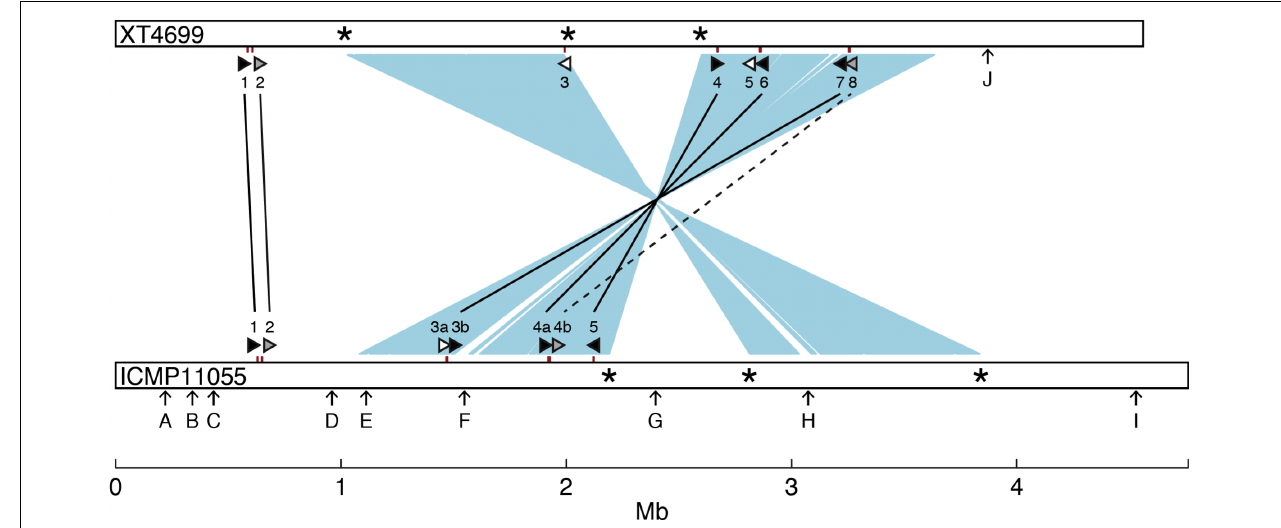
FIGURE 3 | Comparison between the genomes of X. translucens pv. undulosa strains ICMP11055 and XT4699. The genomes are represented linearly as open bars. Two major inverted and rearranged regions are indicated by light blue shading between the genomes. Asterisks mark IS elements present at the termini of the rearranged regions. Tick marks on the genomes indicate the locations of tal genes. The tal genes are also represented, not to scale, as triangles (see Figure 4 for RVD sequences). Perfectly or nearly perfectly conserved (1 or 0 RVD differences) tal genes are filled black and connected by a solid line. The tal2 gene of ICMP11055 and the XT4699 ortholog, which diverge in the last 5 of the 18 total RVDs, are filled gray and connected by a solid line. Tal4b of ICMP11055 and Tal8 of XT4699, which show partial RVD sequence similarity, are filled gray and connected by a dashed line. The remaining tal genes, unique to each strain, are filled white. Arrows labeled with a capital letter mark genomic regions unique to one or the other strain, as follows: A 10 kb genomic region, encoding putative VGR related proteins for Type VI secretion; B, 14 kb genomic region comprising Types II and IV secretion system genes; C, 15 kb region, encoding a CRISPR gene cluster; D, 12 kb region, harboring phage related genes; E 11 kb region, harboring coding sequences for cyclolysin secretion ATP-binding protein, hemolysin secretion protein D, and alkaline phosphatase; F, containing putative VGR related protein genes for Type VI secretion and phage related genes; G, 15 kb region, encoding phage related proteins; H, 54 kb region, encoding phage related proteins; I, 15 kb region, encoding putative VGR related proteins for Type VI secretion; J, 10 kb region, with genes for type III restriction and modification